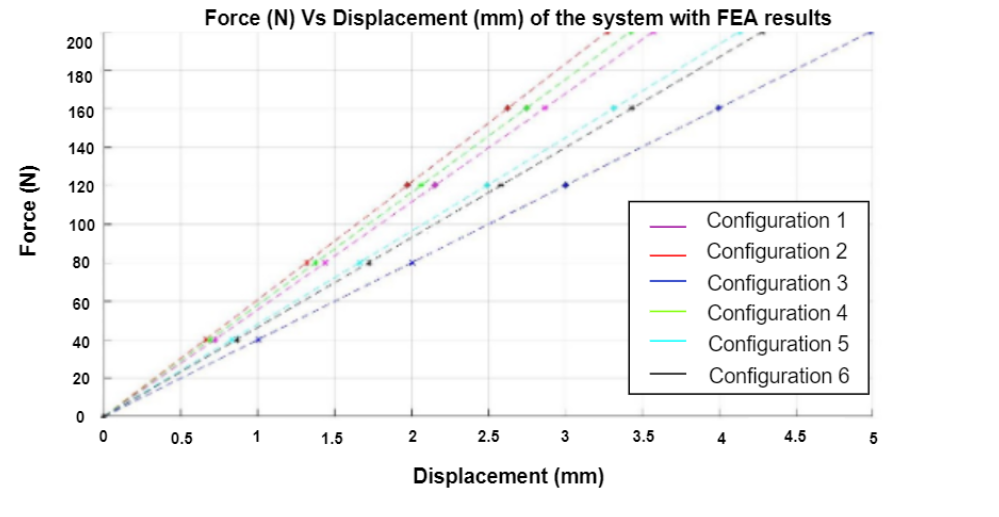
Figure 20. Force displacement graph based on FEA results. Configuration 1—Magenta, Configuration 2—Red, Configuration 3—Blue, Configuration 4—Green, Configuration 5—Cyan, Configuration